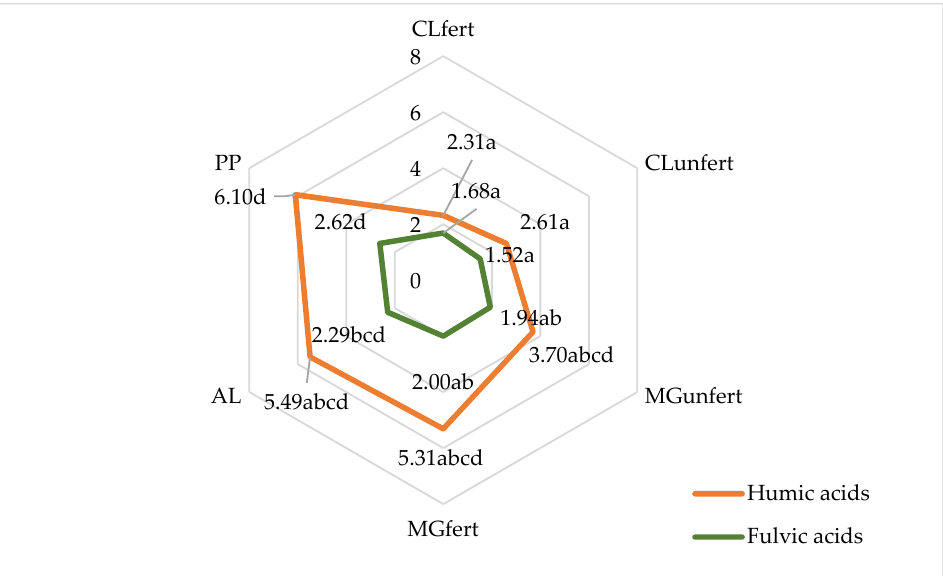
Figure 3. Humic and fulvic acids stocks (t ha − 1 ) in A horizon. Note. Abbreviations: CLfert: cropland fertilized; CLunfert: cropland unfertilized; AL: abandoned land; MGunfert: managed unfertilized grassland; MGfert: managed fertilized grassland; AL: abandoned land; PP: pine plantation. Lowercase letters indicate HA and FA stock differences among land uses.